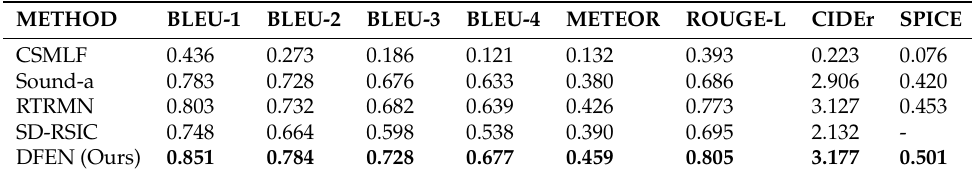
Table 1. Results of different models on the UCM-caption dataset.